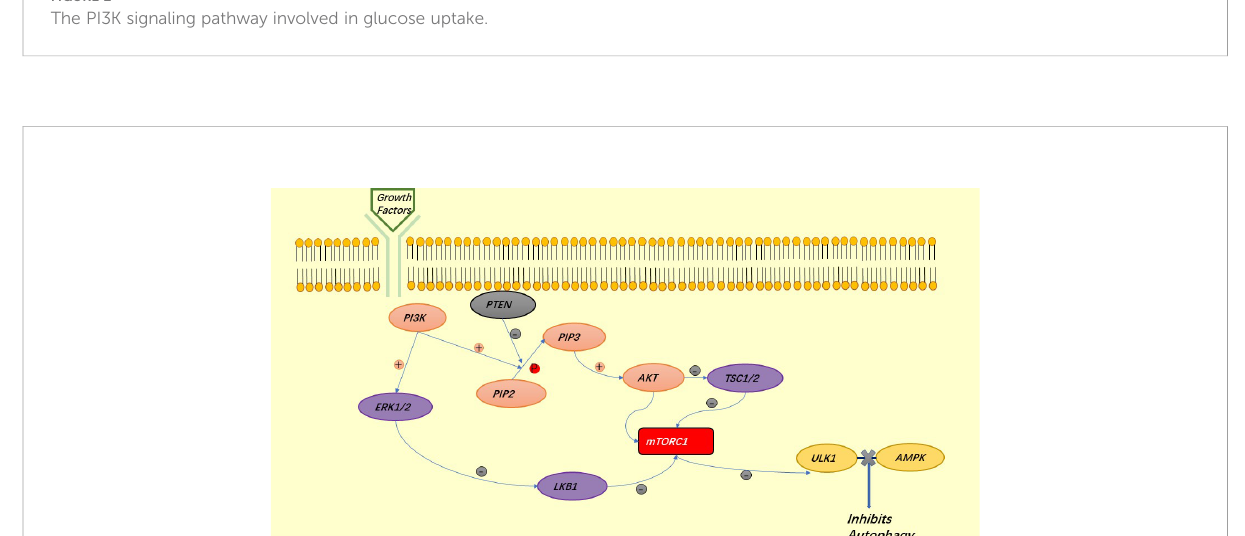
FIGURE 3 The PI3K signaling pathway involved in the regulation of autophagy.